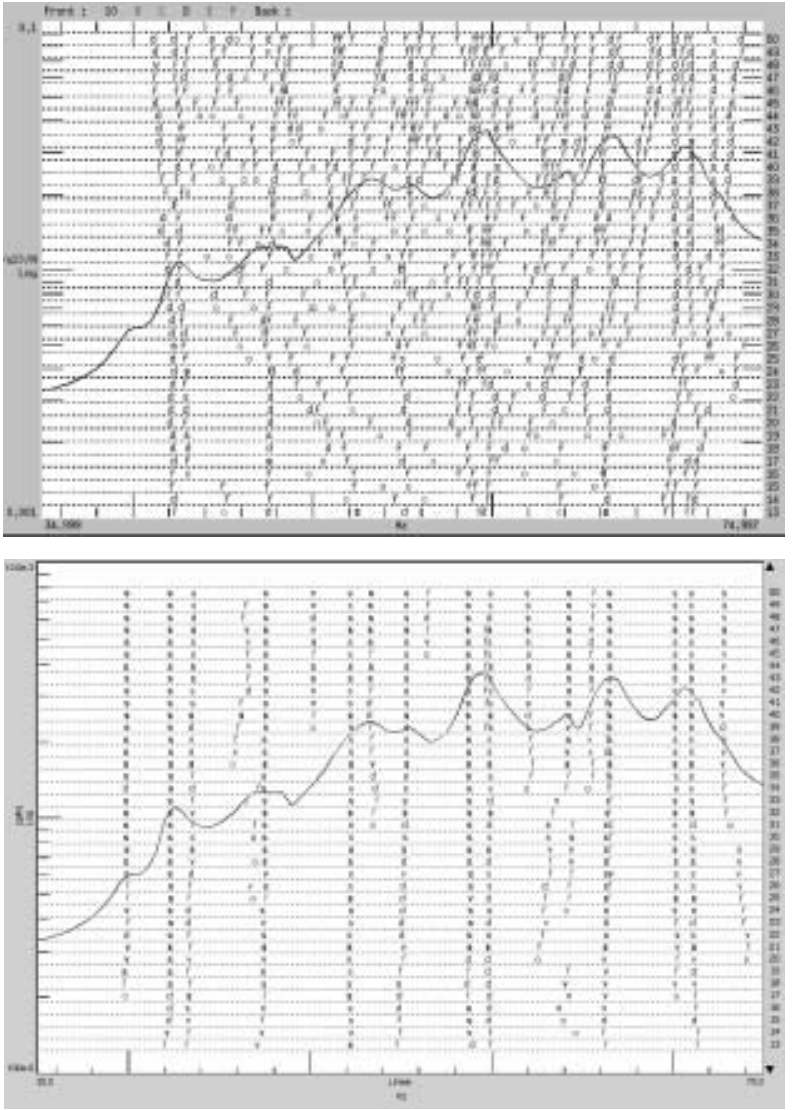
Fig. 4. Stabilisation diagrams obtained by applying different parameter estimation methods to data from a partially trimmed car: (Top) FDPI; (Bottom) the new PolyMAX